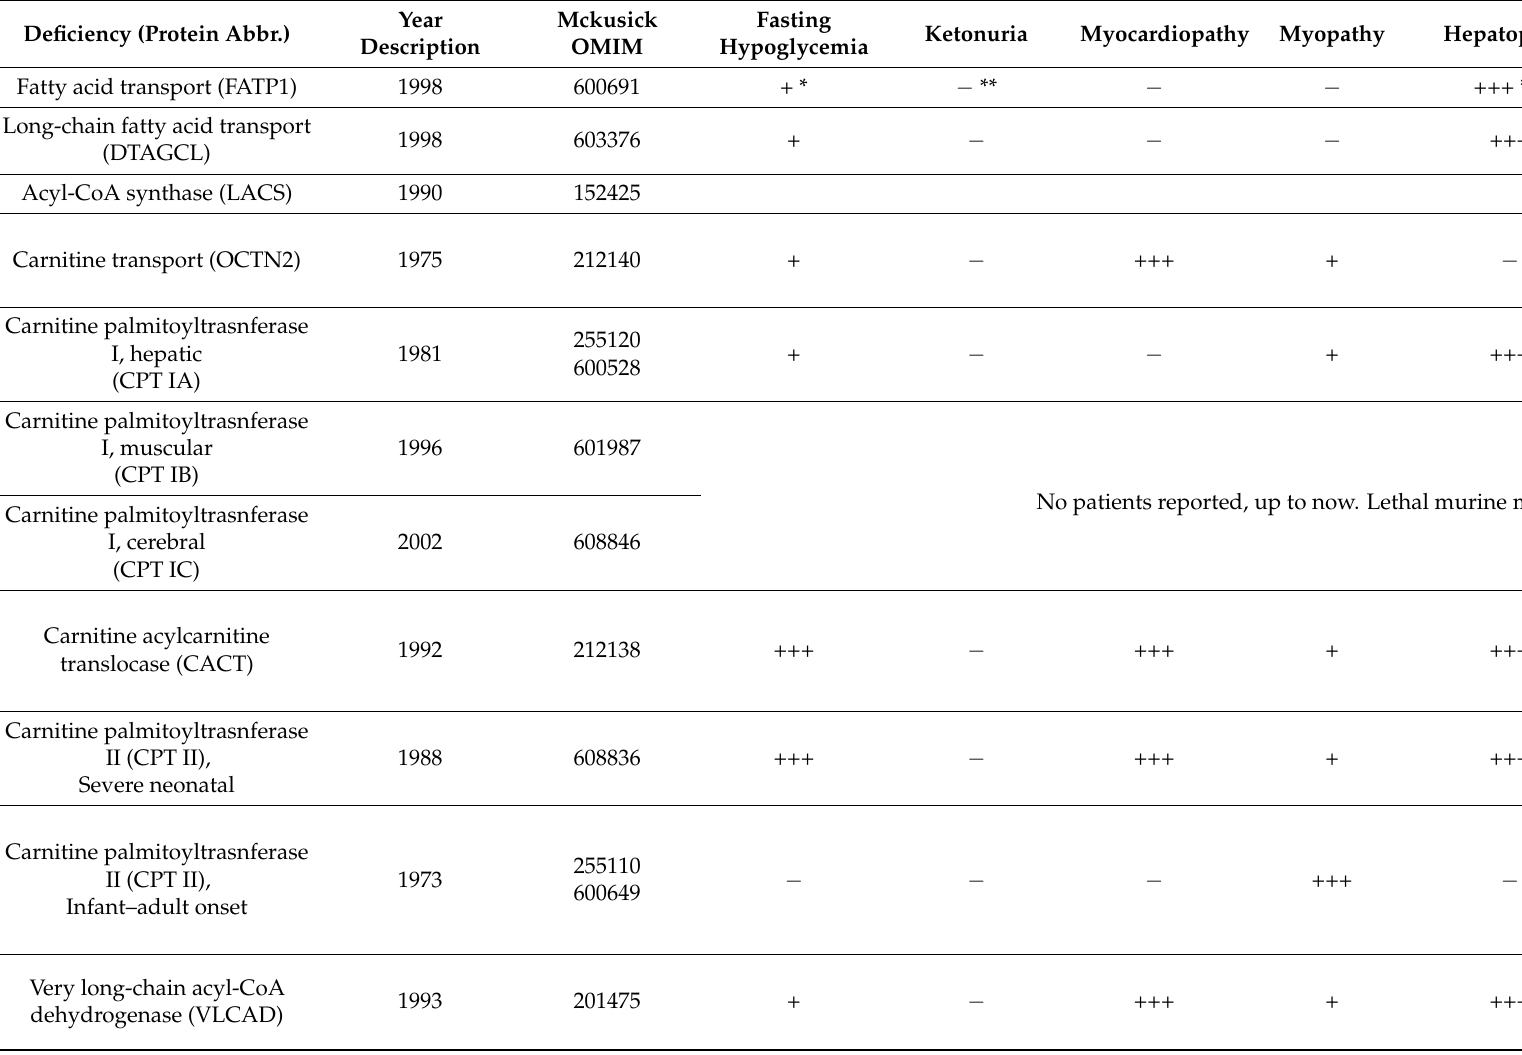
Table 1. Clinical manifestations in mitochondrial fatty acid and carnitine system